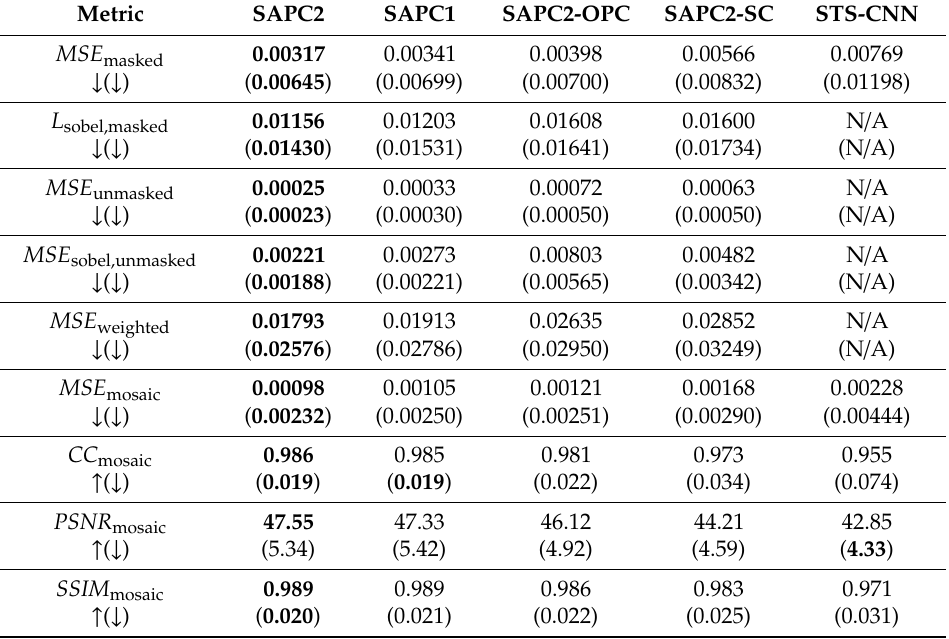
Table 1. Means and standard deviations of nine validation metrics for the proposed model (SAPC2) and the four baseline models (SAPC1, SAPC2-OPC, SAPC2-SC, and STS-CNN). The top value in each box is the mean value of the row’s metric for the column’s model, and the bottom value in the parentheses in each box is the corresponding standard deviation value. The arrows beneath each metric name indicate whether a greater or less value is better for the metric: the arrow on the left side is the indicator for the mean value and the arrow in the parentheses on the right side is the indicator for the standard deviation value. The best values for each metric (i.e., for each row) are bolded. Since STS-CNN returns close-to-zero values in the unmasked part, four metrics (i.e., L sobel,masked